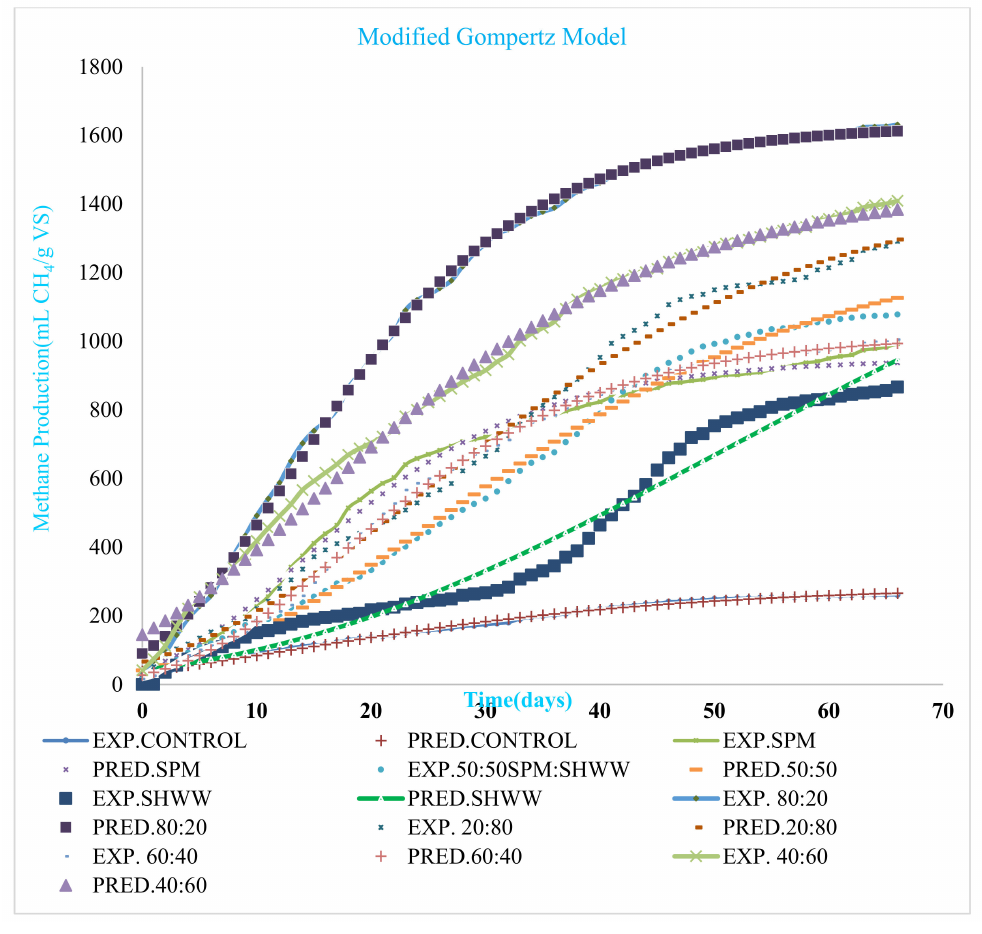
Figure 2. Experimental and simulation lines of cumulative methane production from different substrate mix